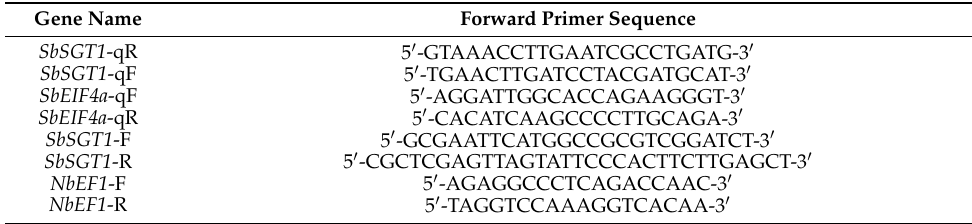
Table A1. Primer sequences.